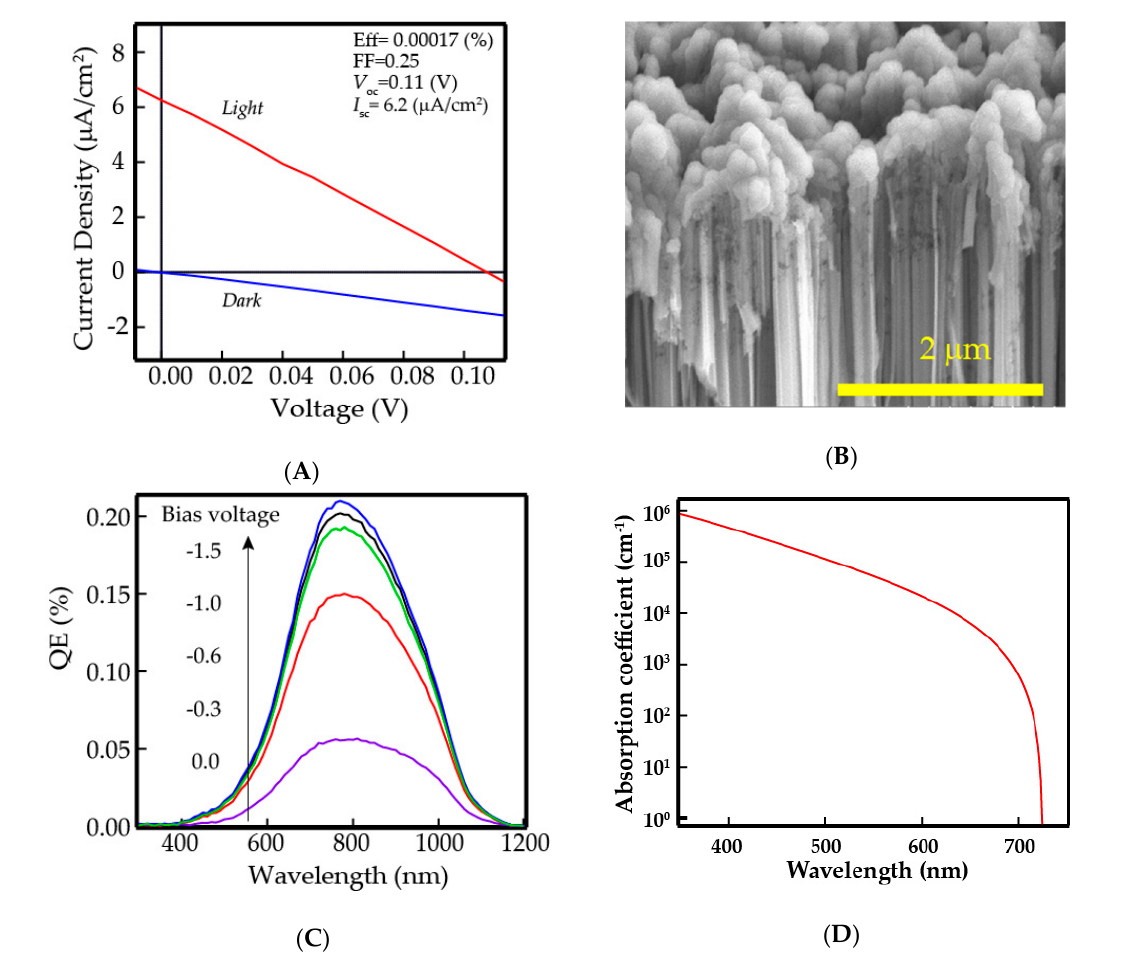
Figure 6. ( A ) I–V characteristics of the solar cell with an optimum SiNW absorber layer fabricated on an SOI substrate. ( B ) Cross-sectional SEM image of the SiNW array surface after the application of the n-type a-Si:H layer. ( C ) Quantum efficiency (QE) of the solar cell under a changing negative voltage from 0–1.5 V. ( D ) Absorption coefficient of n-type a-Si measured via spectroscopic